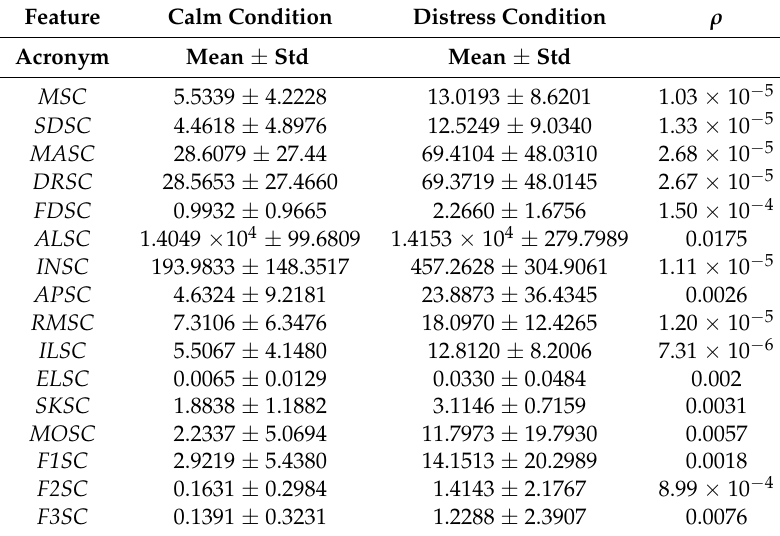
Table 2. Results obtained from skin conductance response (SCR). Mean and standard deviation values for emotional states of calm and distress, and statistical significance ( ρ ), for all parameters are